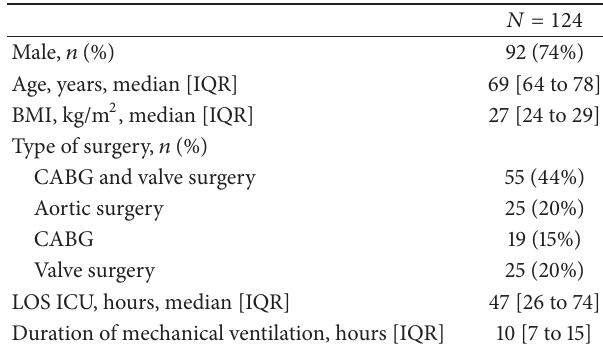
Table 1: Patient